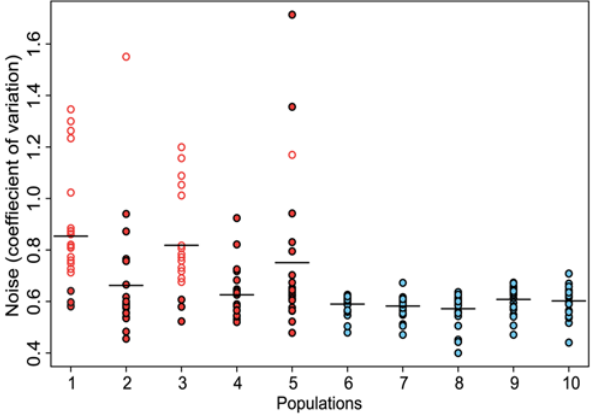
Figure 1. Noise in GFP expression in clones from selected and control populations. Clones from selected populations (red) show a higher level of noise than do clones from control populations (blue) (univariate GLM, p=0.016). Open circles indicate clones that contain the promoter sequence for the fliC gene driving GFP expression, which were significantly enriched in the selected populations. Each data point represents the coefficient of variation of the GFP expression of several thousand individual